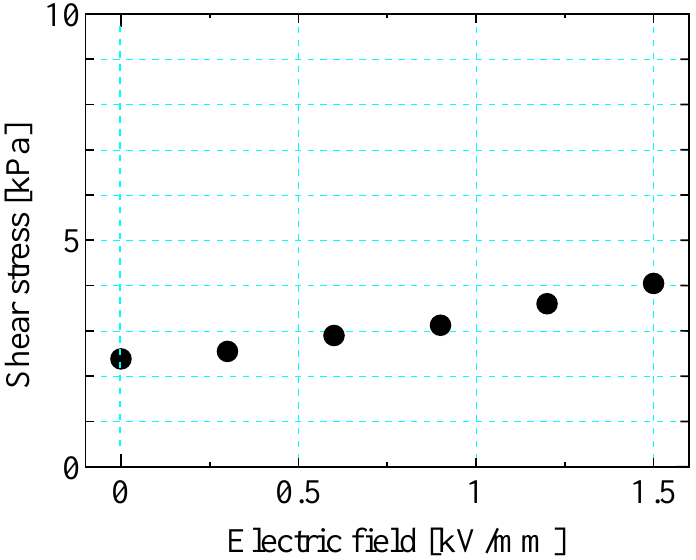
Figure 11. Shear stress of a winding EA gel sliding orthogonally.